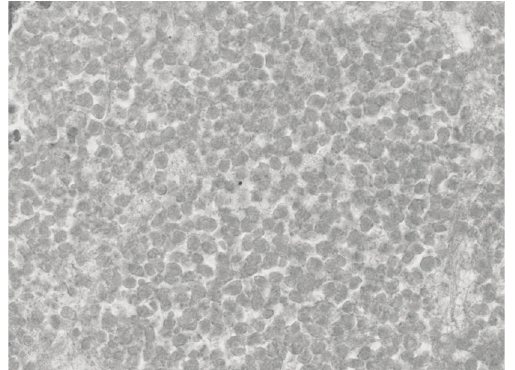
Figure 7: Histological findings of the HE-stained resected sections (magnification: x36). The tumor cells completely showed necrotic